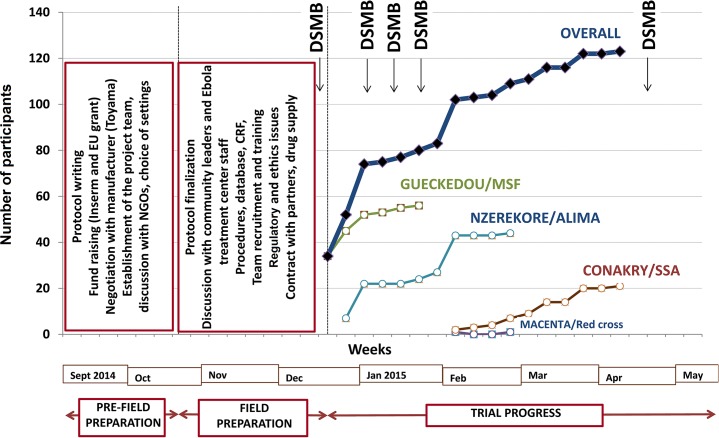
JIKI trial progress.ALIMA, Alliance for International Medical Action; CRF, Croix Rouge Française (French Red Cross); EU, European Union; Inserm, Institut National de la Santé et de la Recherche Médicale; SSA, Service de Santé des Armées (French military health service).